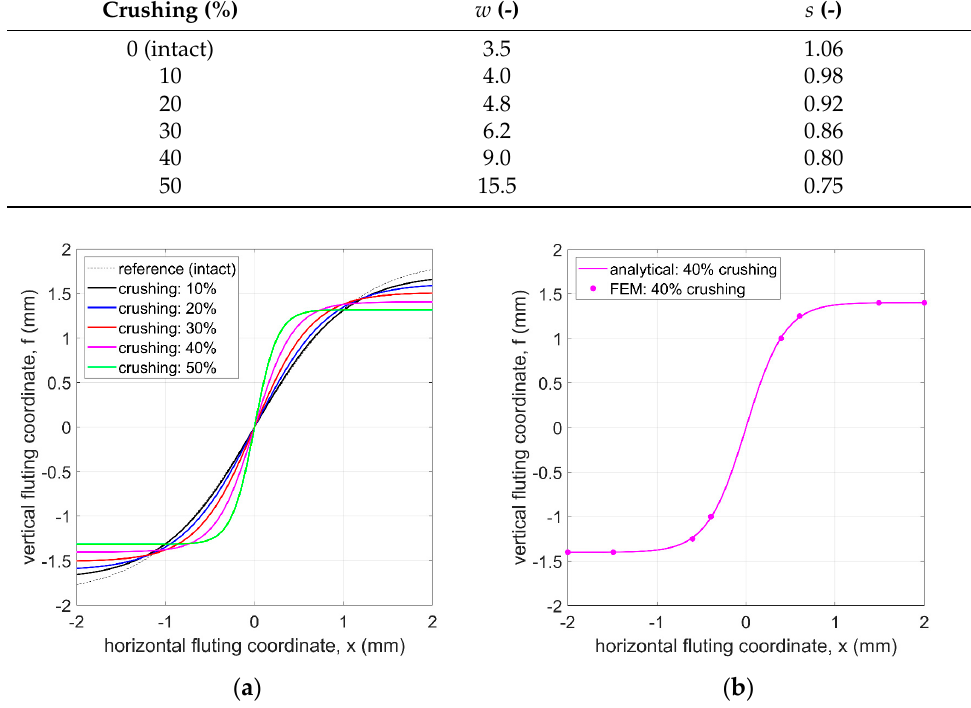
Figure 8. Half-waves of fluting due to crushing obtained from the analytical formula (4) and parameters presented in Table 2: ( a ) shapes of the flute corresponding to different levels of crushing and ( b ) the comparison for 40% of crushing: FEM (magenta circles) vs analytical formula (solid line).